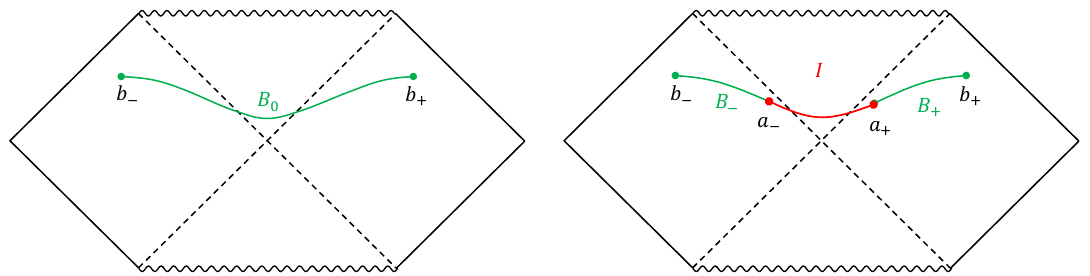
Figure 4 . The statement that the island appears after the Page time naively sounds as if it is absent before the Page time. Then, the region of the black hole subsystem B covers all the other region than R , namely, B = B 0 (left). However, the black hole subsystem would be able to separated into that in the left wedge B − and that in the right wedge B + . Information of the island I cannot be reproduced by either of B + or B − , and the region B contains the island I , namely, B 0 = B ∪ I , where B = B + ∪ B − (right).